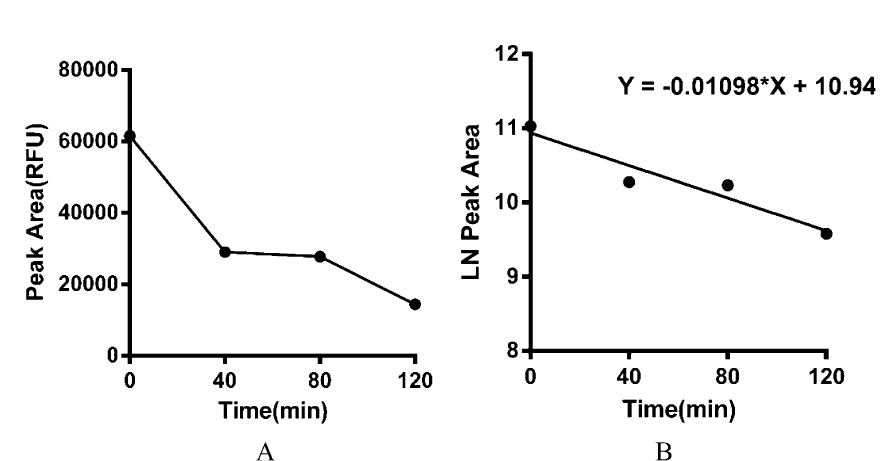
Figure 12. Analysis of the process and rate of DNA degradation in the mouse gastrointestinal tract over time, on the basis of STR assays. ( A ): average peak area of the stomach contents in mice at different digestion times. ( B ): linear regression analysis of the natural logarithm of the average peak area versus digestion time (half-life: 63.13 min).